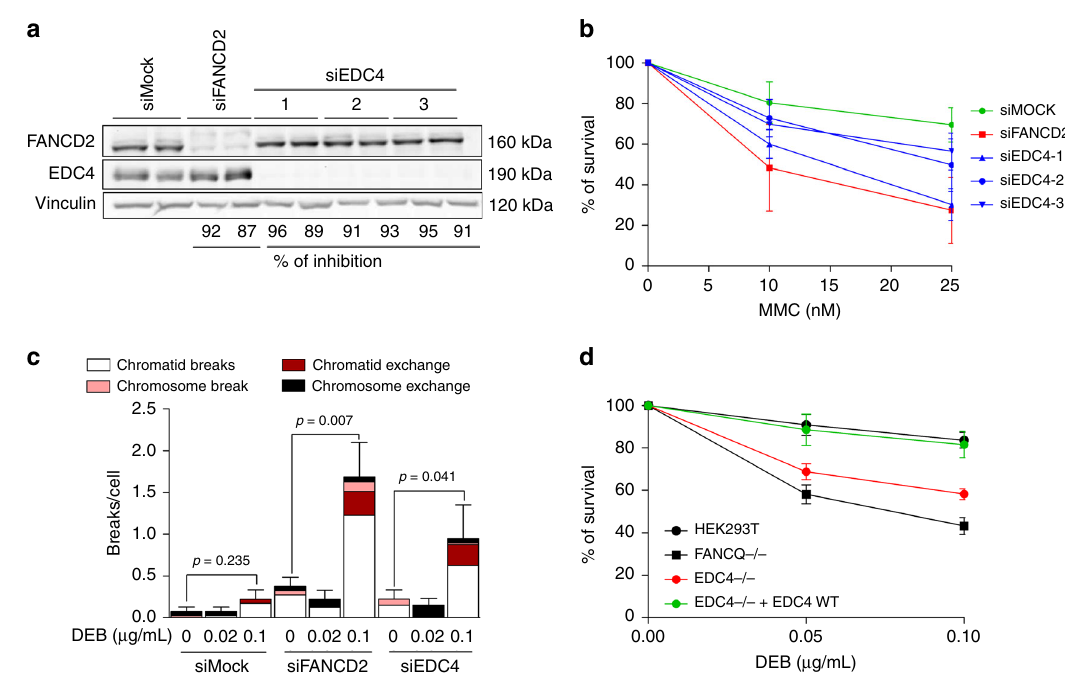
Fig. 2 EDC4 is required for genome maintenance. a Immunoblots showing the inhibition ef fi ciency in HeLa cells of FANCD2 and EDC4 by three different siRNA sequences used. Two replicas are shown for inhibition. b Inhibition of EDC4 reduces the survival of HeLa cells exposed to MMC. Data shown represent results from fi ve independent experiments. Error bars indicate mean ± s.d. Means were statistically compared using the two-tailed Student ’ s t test. Statistical analysis comparing the means of the Mock-treated vs. siRNA-treated samples were performed with the following p values: siFANCD2 (10 nM, p = 0.0376; 25 nM, p = 0.0114), siEDC4-1 (10 nM, p = 0.0747; 25 nM, p = 0.0018), siEDC4-2 (10 nM, p = 0.0227; 25 nM, p = 0.0199), and siEDC4-3 (10 nM, p = 0.2004; 25 nM, p = 0.0028). c EDC4 depletion causes chromosome fragility after DEB exposure in primary fi broblasts. Data shown represent results from the analysis of 40 metaphases (two experiments of 20 metaphases each one). Error bars indicate mean ± s.e.m. The statistical test performed in each inhibition to compare breaks per cell (0 vs. 0.1 µ g/mL DEB) was a Mann – Whitney test. d CRISPR/Cas9-generated EDC4 − / − HEK293T cell line shows a decrease in survival after DEB treatment that is reversed when the WT EDC4 is expressed. Data shown represent results from four combined independent experiments. Error bars indicate mean ± s.d. Means were statistically compared using the two-tailed Student ’ s t test. Statistical analysis comparing the means of the WT cell line with the samples were performed with the following p values: FANCQ − / − ( p = 0.001; p = 0.001), EDC4 − / − ( p = 0.000; p = 0.000), and EDC4 corrected ( p = 0.613; p =